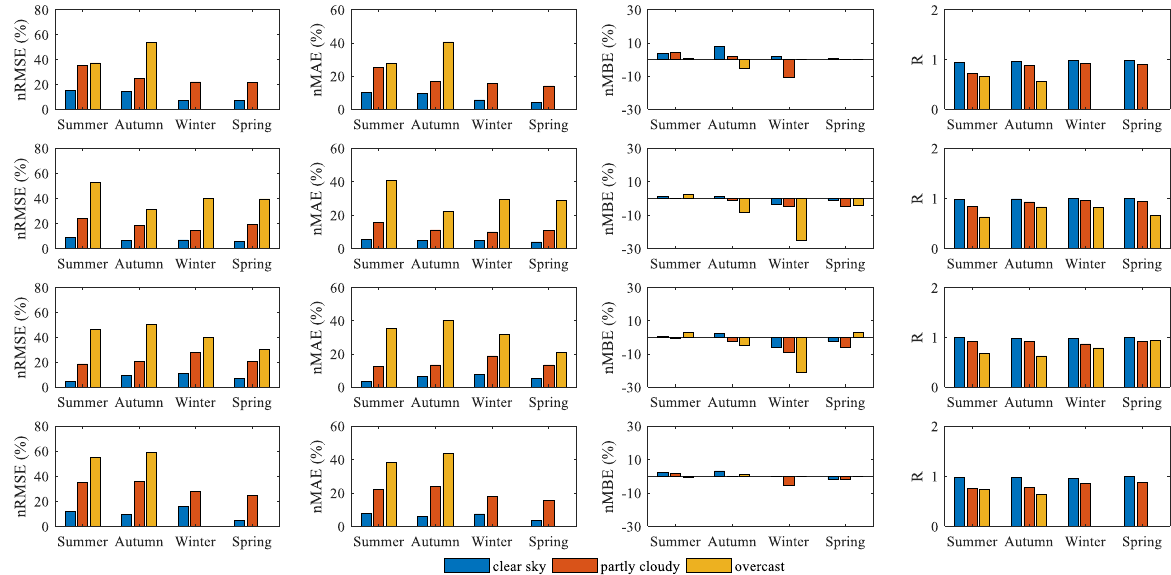
Figure 5. The variation of estimated GHI under different seasons and different weather conditions (top row: Zhangbei; second row: Laoting; third row: Hengshui; bottom row: Chengde).